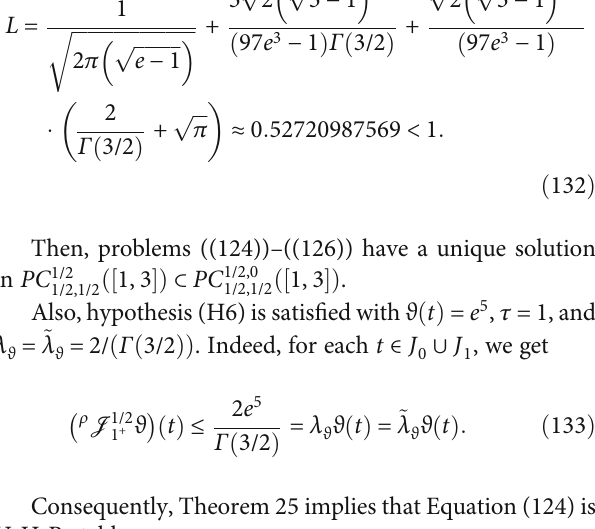
ffiffiffi p 3 − 1